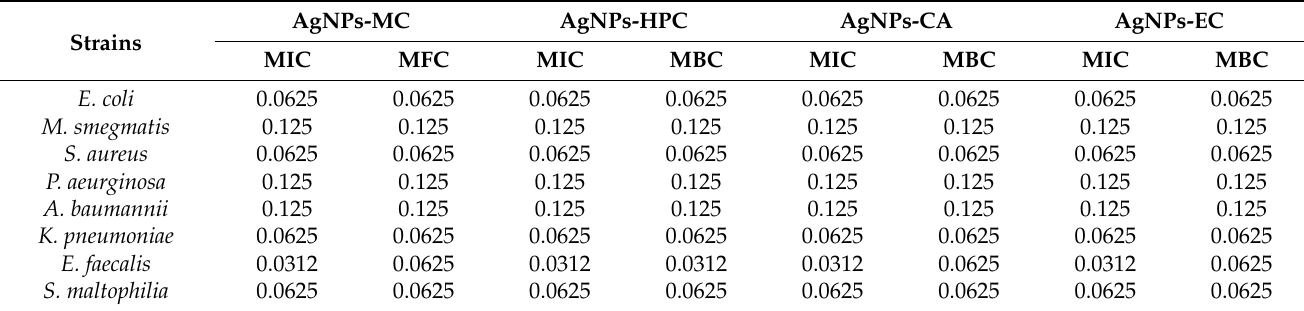
Table 5. Antibacterial activity (MIC, MBC; mM) of